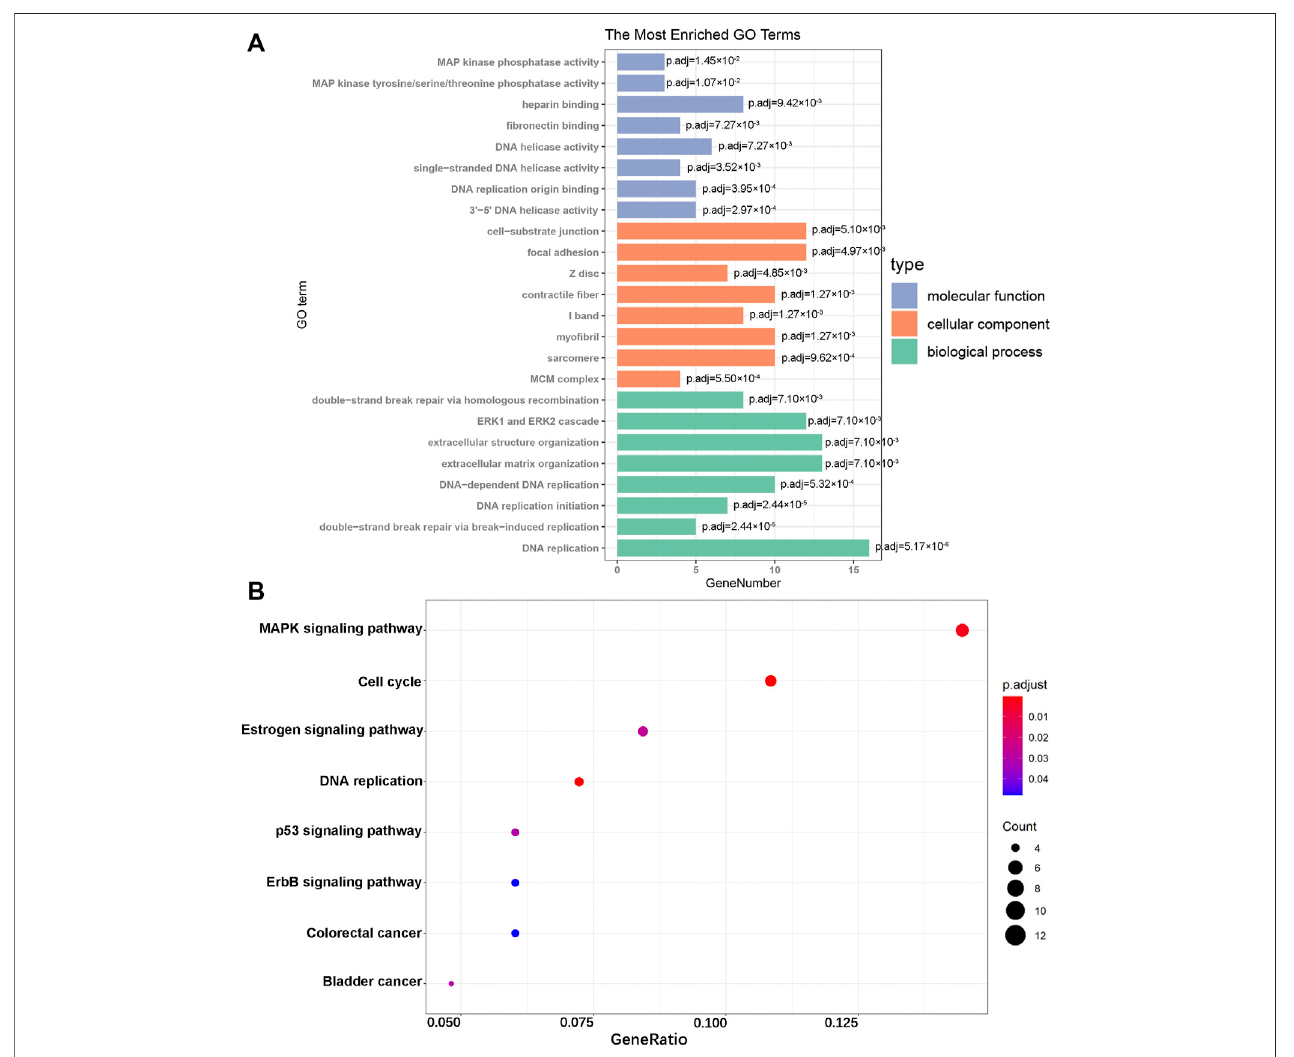
FIGURE 3 | GO enrichment and KEGG pathway analyses. (A) GO analysis of the DEGs. (B) KEGG pathway analysis of the DEGs.